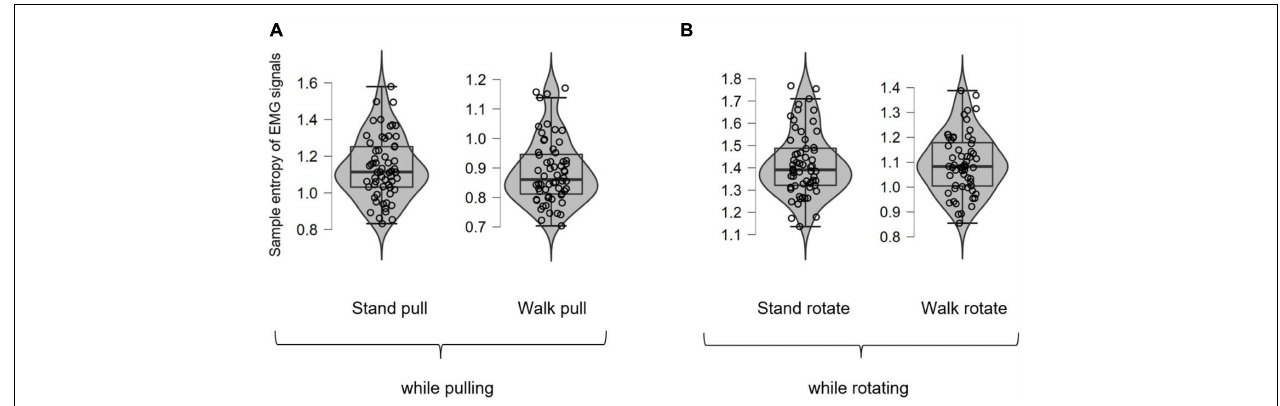
FIGURE 9 | The box plots for the sample entropy of EMG signals in walking and standing while pulling (A) and rotating (B) .